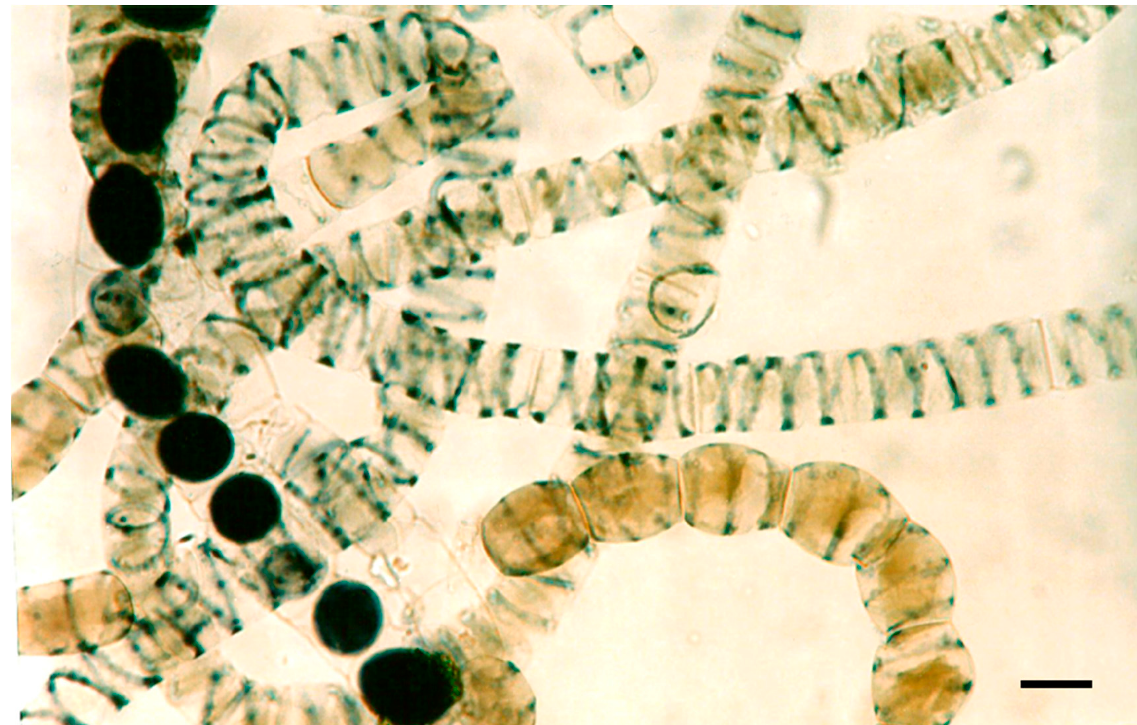
Figure 1. Spirogyra under microscopic view (Scale bar, 30 μ m).